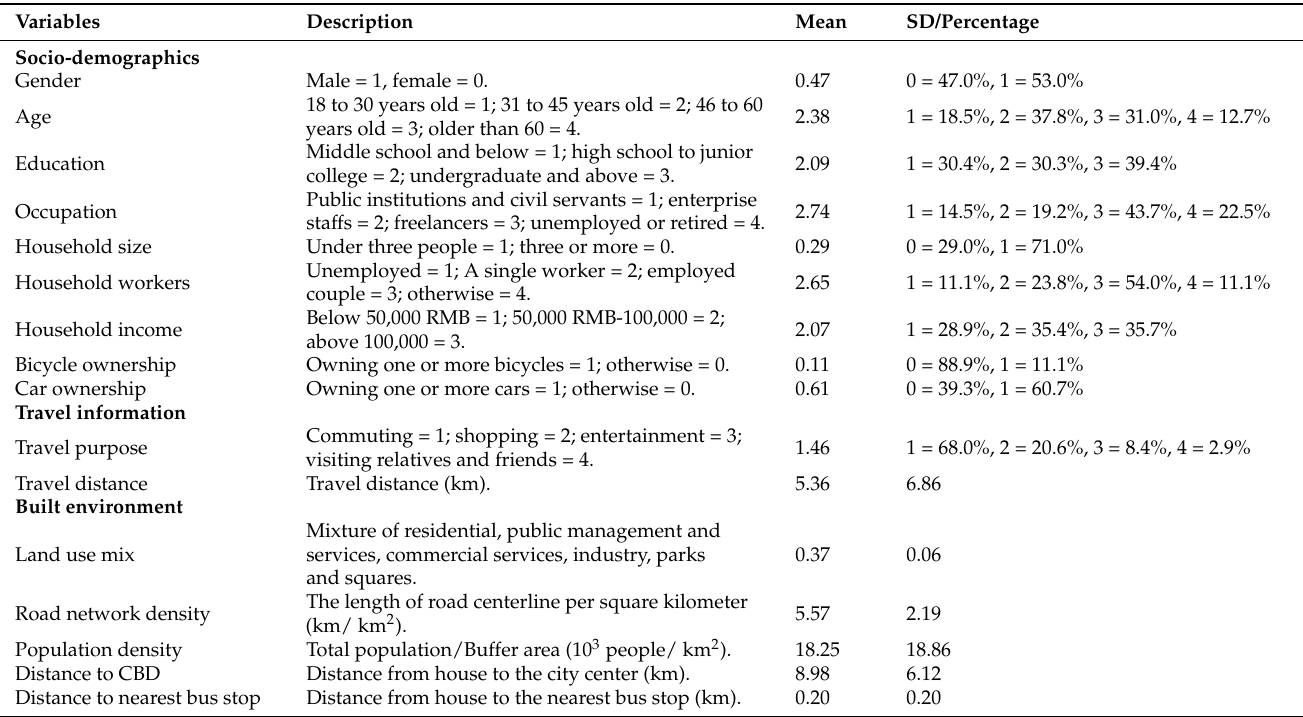
Table 1. Descriptive statistics of explanatory